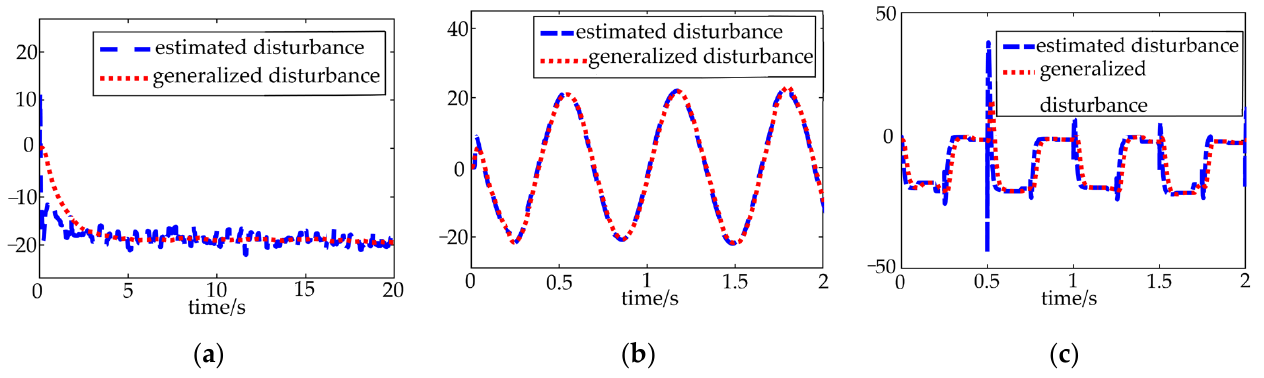
Figure 5. The perturbation estimation under the different tracking, ( a ) the perturbation estimation under the step signals, ( b ) the perturbation estimation under the sign signals, ( c ) the perturbation estimation under the square wave signals.